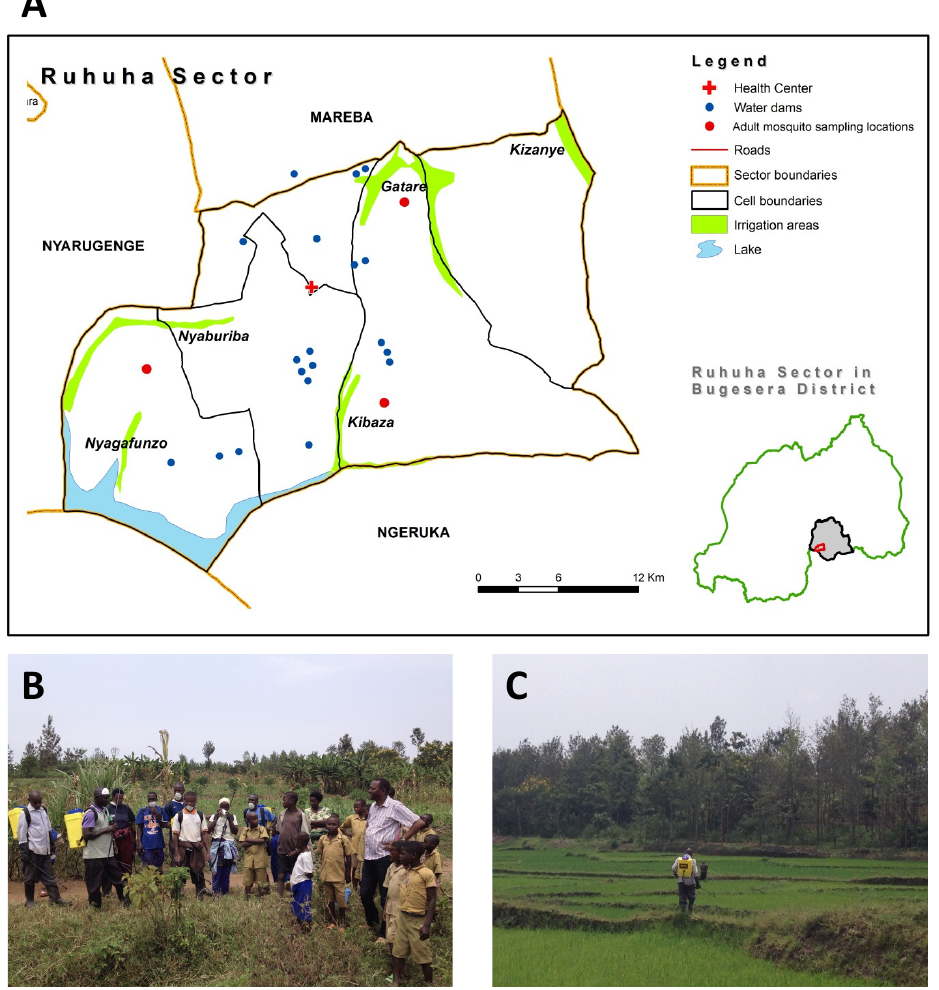
Figure 1. ( A ) Location of the experimental sites in Ruhuha, southeast Rwanda. Nyaburiba: rice field control, Gatare: rice field-1 for community-based application of Bti (CB1), Kizanye: rice field-2 for community-based application of Bti (CB2), Kibaza: rice field-1 for expert supervised application of Bti (ES1), Nyagafunzo: crop land-2 for expert supervised application of Bti (ES2). Blue dots represent the 19 water hill dams at which expert-supervised application of Bti (ES3) was also carried out. ( B ) Training of community representatives for spraying of Bti . ( C ) Spraying of Bti using knapsack sprayers in the irrigated rice fields.